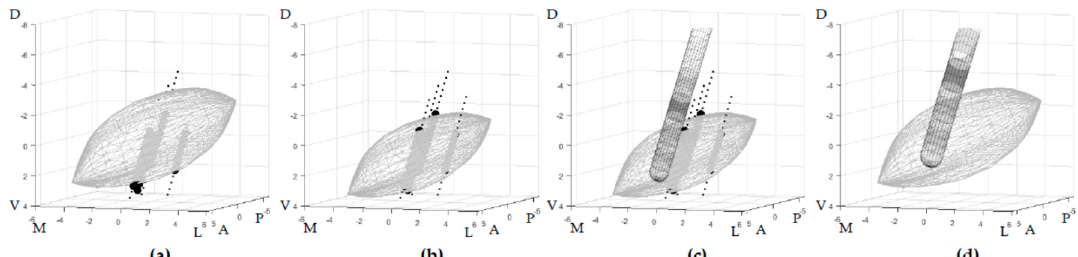
Figure 1. Anterolateral view of the subthalamic nucleus (STN) in an AC–PC-aligned orientation illustrating how the contact locations were expressed in reference to the generalized STN. ( a ) The atlas-derived generic 3D STN shape is placed on top of the patient-specific MER sites ( ∙ = outside STN, • = inside STN); ( b ) the STN is transformed to optimally fit the classifications of all MER sites; ( c ) the DBS electrode and its contacts, recognized in MRI-fused CT images, are combined with the MER-based STN using the patient-specific stereotactic frame (active contact after one year in darker gray); ( d ) both the MER-based STN and the recognized electrode are inversely transformed together. All the electrode contacts are now expressed in reference to the generalized STN in an AC–PC-aligned orientation. (A = anterior, D = dorsal, L = lateral, M = medial, P = posterior, and V = ventral, locations displayed on the axes are in